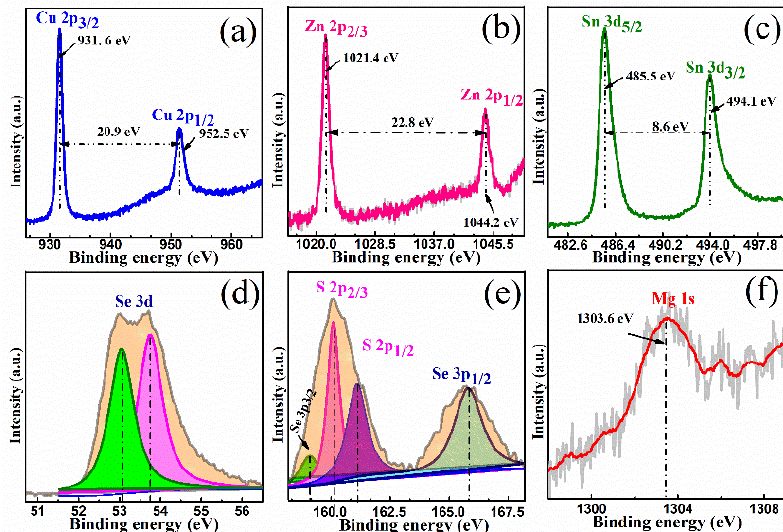
Figure 3. X-ray photoelectron spectroscopy (XPS) spectra of CMZTSSe films annealed at 530 °C for 15 min: ( a ) Cu, ( b ) Zn, ( c ) Sn, ( d ) Se, ( e ) S, and ( f ) Mg.